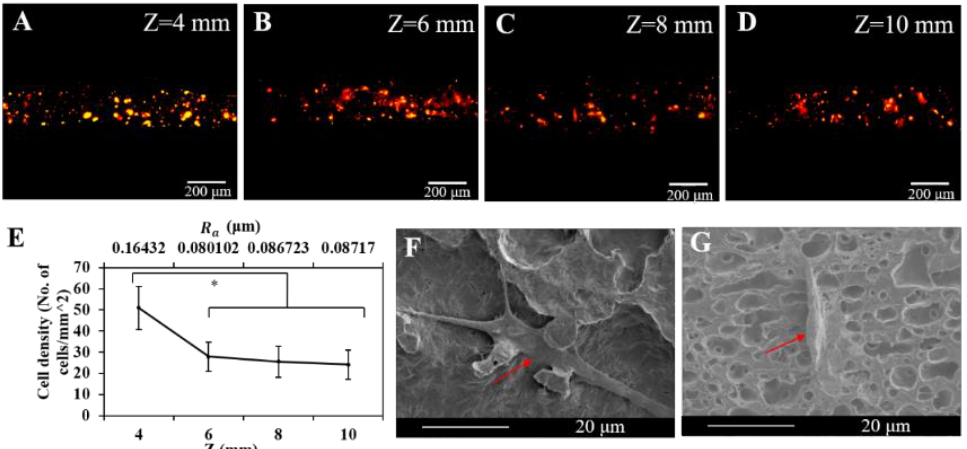
Figure 8. Fluorescence images of cells tracking after culturing the cell-laden samples for 3 days: ( A ) Z = 4 mm, ( B ) Z = 6 mm, ( C ) Z = 8 mm, ( D ) Z = 10 mm. ( E ) The correlation between cell density seeded on fibers fabricated at 3.5 kV, 30 μl/min and different Z and 𝑅 𝑎 (* represents p < 0.01). ( F ) SEM images of cells (red arrow shows) seeded on fibers fabricated at Z = 4 mm. ( G ) SEM images of cells (red arrow shows) seeded on fibers fabricated at Z = 10 mm.